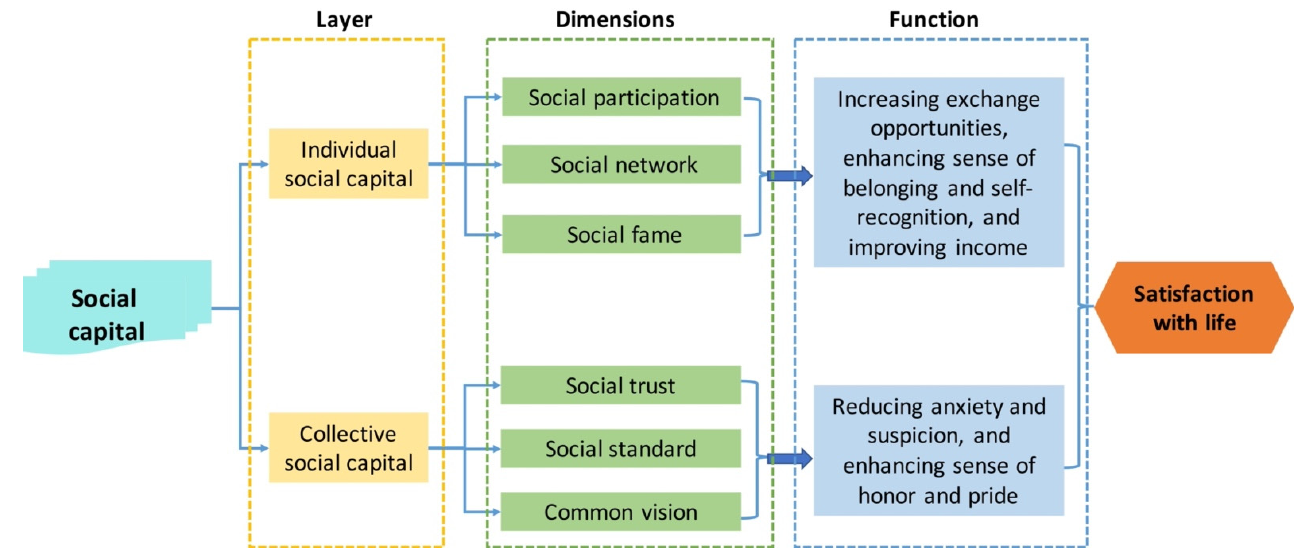
Figure 3. Theoretical analysis framework for the influence of social capital over the subjective well-being of farmers and herdsmen.